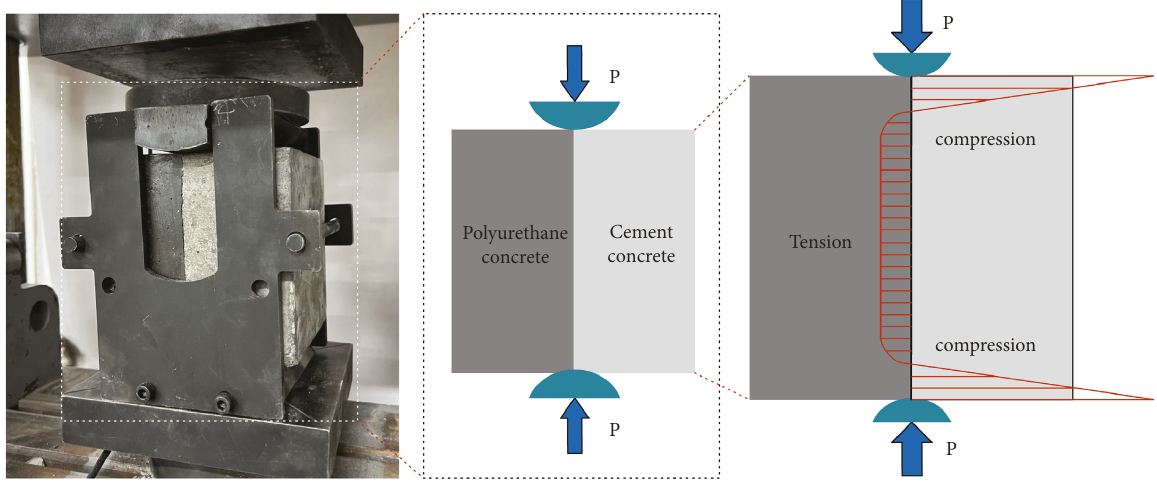
Figure 9: Bond splitting strength